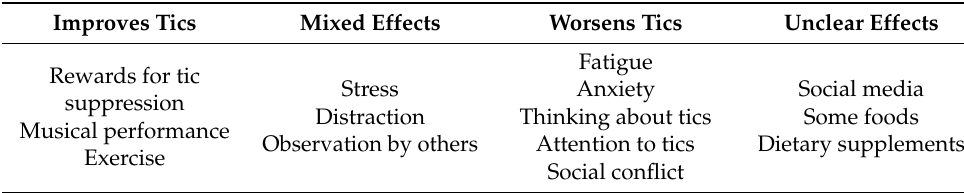
Table 1. Summary of factors that impact